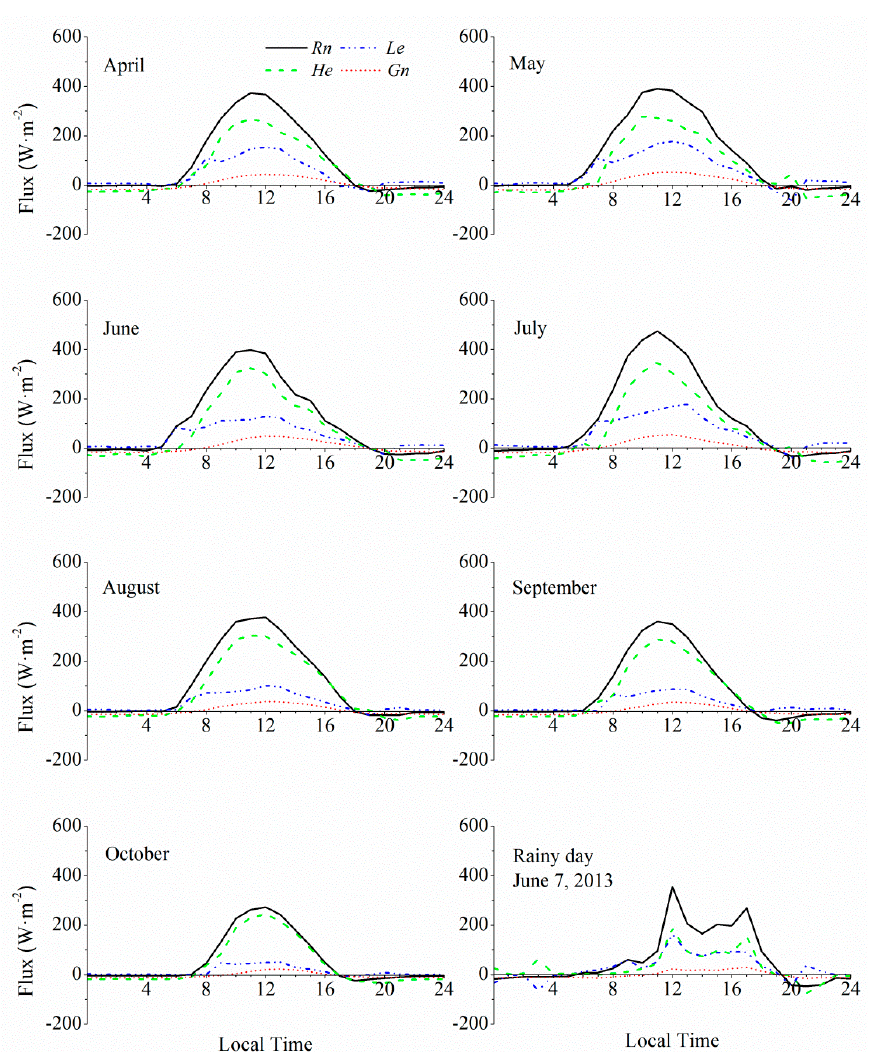
Figure 2. Diurnal cycle of energy partitioning into net radiation ( Rn ), sensible heat flux ( He ), latent heat flux ( Le ), and ground heat flux ( Gn ) for each month of the growing season from 2013 to 2015.